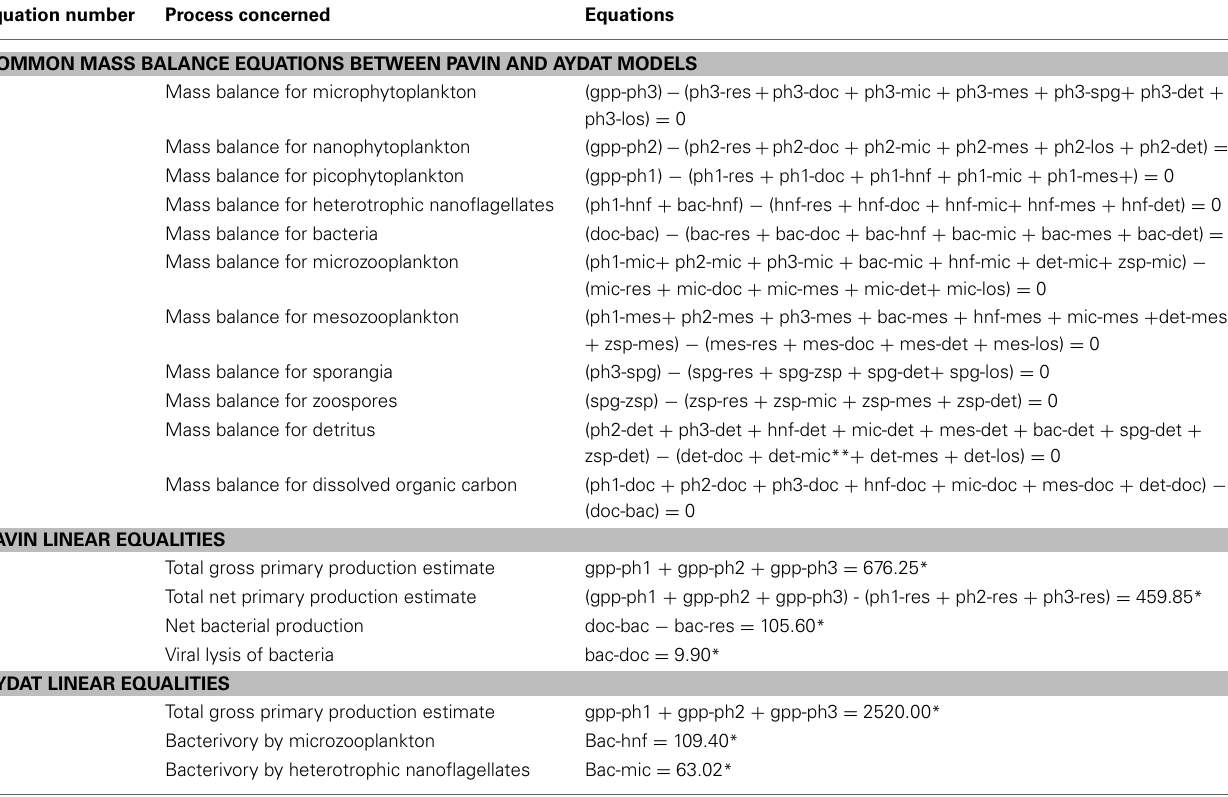
Table 1 | Mass balance (1–11) and linear equations used for inverse